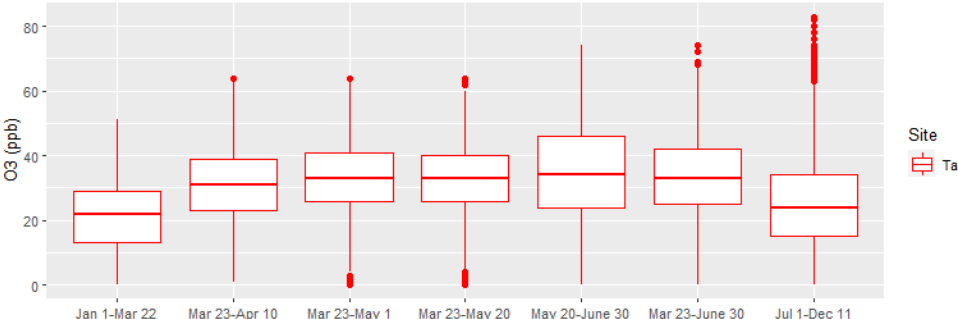
Figure 13. Boxplots of hourly O 3 during each time period of interest during 2020 at the Taft site.